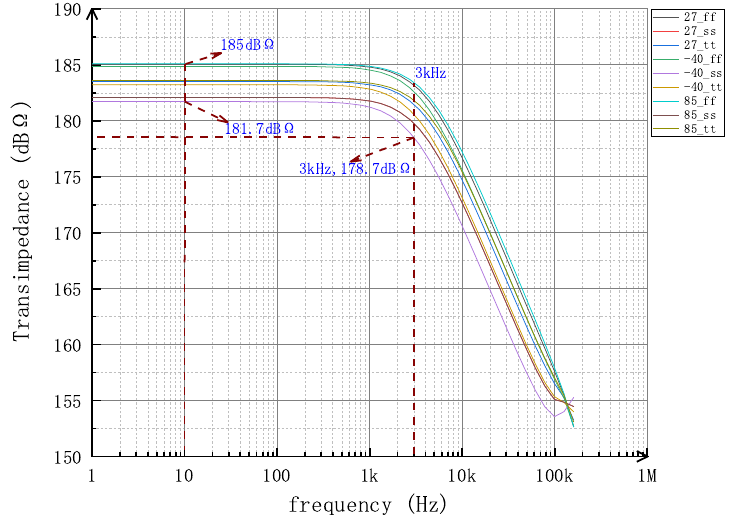
Figure 14. Frequency response of the input node of the